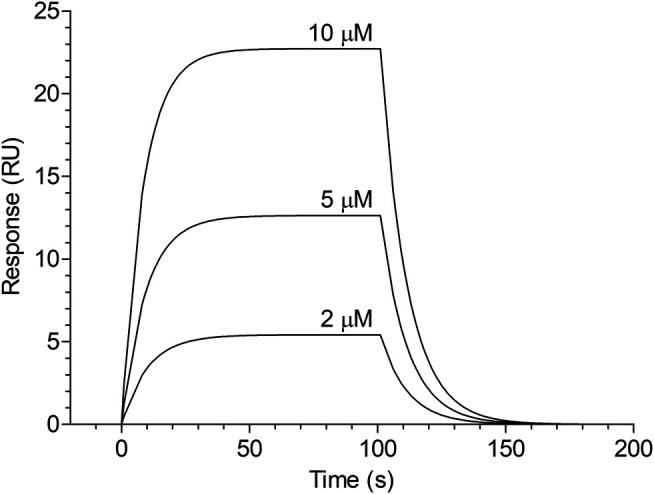
Surface plasmon resonance sensorgram of cangrelor binding to HSA. HSA was immobilized to a dextran-coated gold surface. Injection of analyte (cangrelor at the concentration of 2, 5, or 10 µM) produced a signal change that was directly proportional to the mass of bound drug molecules, expressed in resonance units (RU). Further details are given in “Materials and Methods” section.